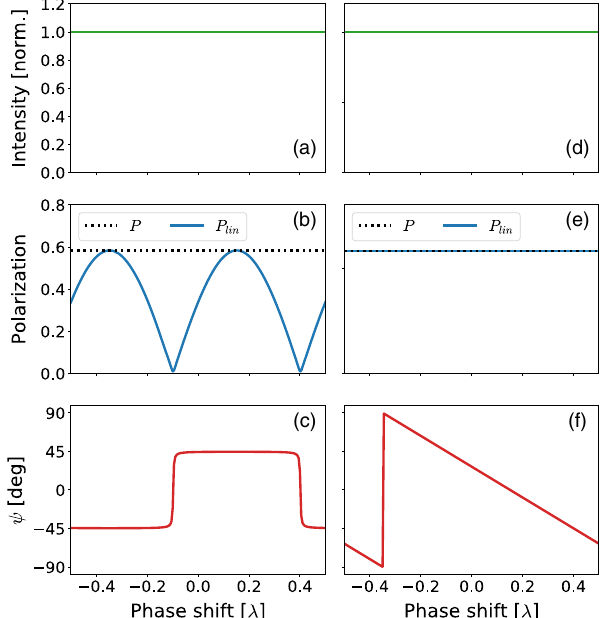
FIG. 8. Model prediction of the XPU scheme. Intensity (a, d) polarization (b, e) and direction (c, f) as a function of the phase between the two sources. The two fields have the same amplitude and linear orthogonal polarization [LV and LH for (a-c), CR and CL for (d-f)], while the distance between the two sources is ∼ 3 z R and the collection aperture is 3 σ both in horizontal and vertical